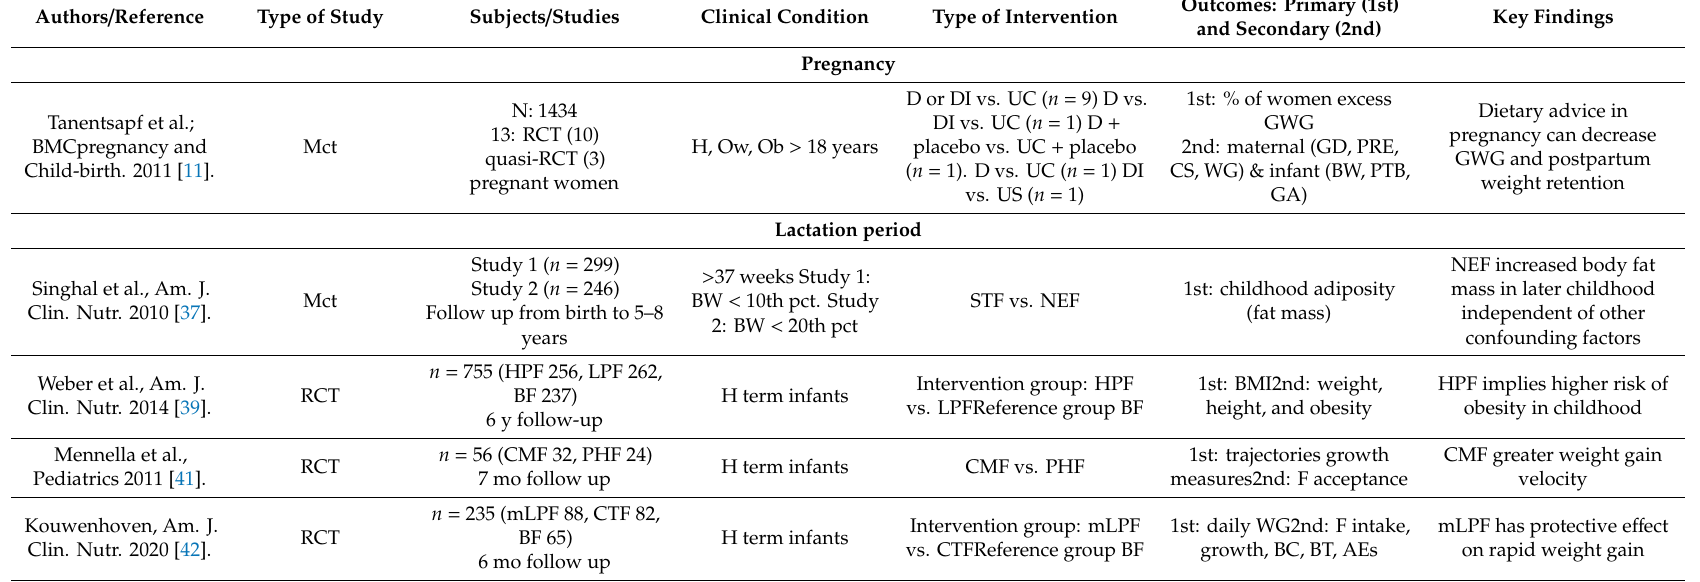
Table 2. Summary of behavioral level interventions included in the